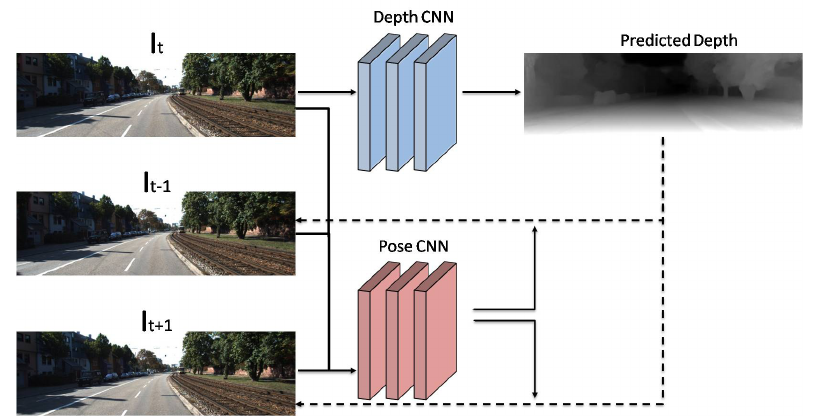
Figure 12. Developed network by Zhou et al.